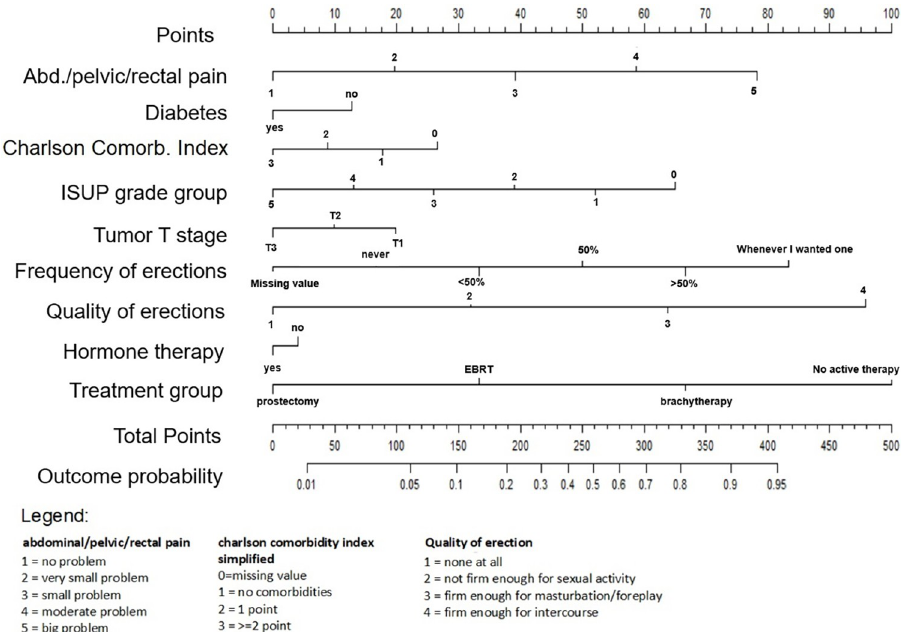
Fig 7. A nomogram of the 2-year erectile dysfunction model. The outcome probability can be calculated by adding the total score and placing it on the total points scale. For example, a man with a very small problem of abdominal pain (20 points), presence of diabetes (0 points), Charlson comorbidity index of 1 (20 points), ISUP grade group of 1 (40 points) tumor stage of T2 (10 points), frequency of erection 50% times (35 points), quality of erection of not at all (0 points), having hormone therapy (0 points), choosing EBRT as treatment (35 points) had a total score of 160 points, indicating a 20% chance of not having ED after 2